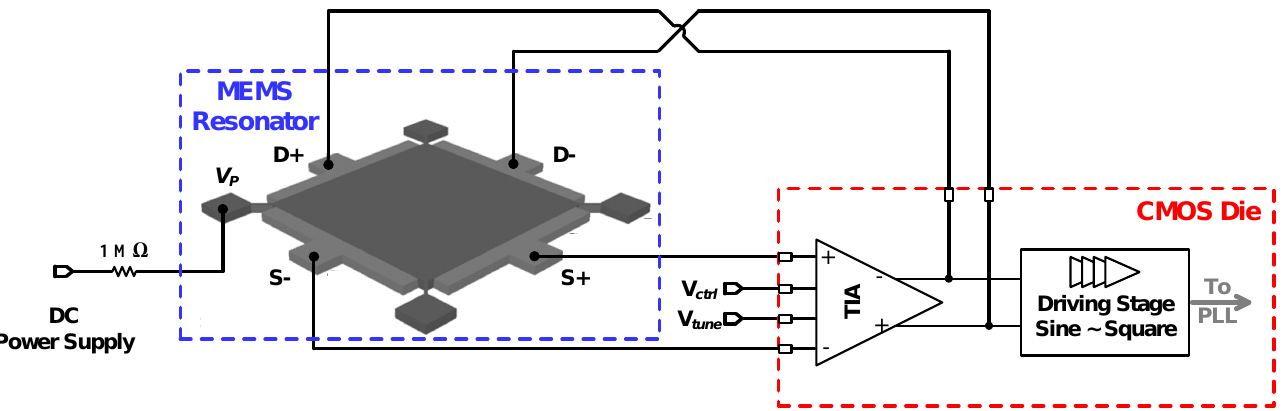
Figure 2. Proposed MEMS-based oscillator block diagram.